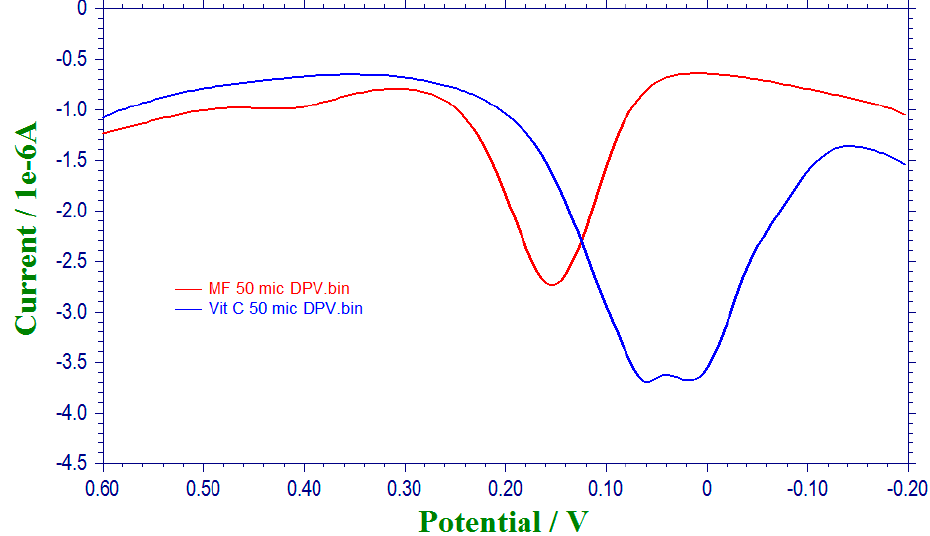
Figure 4. Differential pulse voltammograms of vitamin C (Vit-C) and methanolic fruit (MF). 2.3.3. Antimicrobial Assay of G. latifolia Methanolic Fruit Extract MIC values of methanolic extract against Gram positive and negative bacteria have